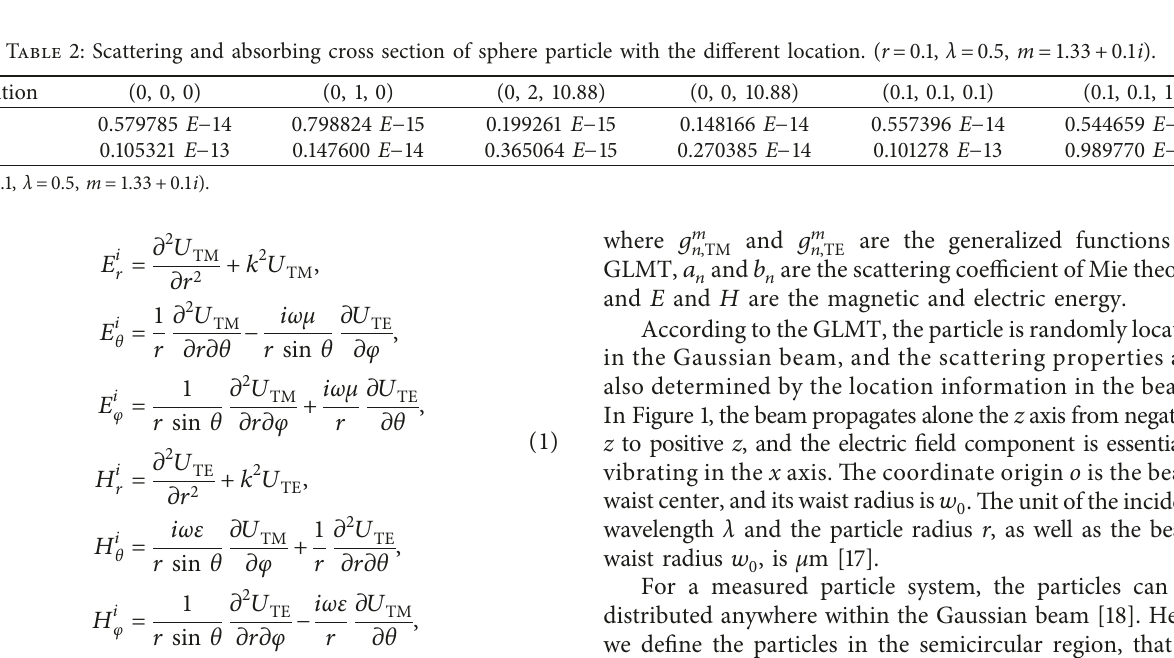
Table 2: Scattering and absorbing cross section of sphere particle with the different location. ( r